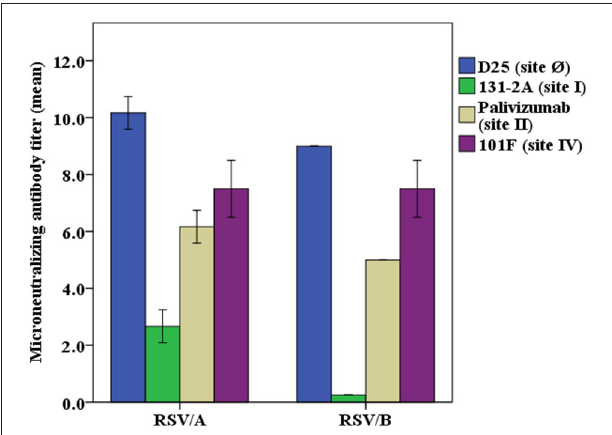
FIGURE 2 | Neutralizing potency of RSV antigenic site-specific monoclonal antibody. RSV/A Tracy and RSV/B 18537 were used in the experiments. The concentration of the mAbs were 40 µ g/mL for D25, palivizumab, 131-2A, and 101F in both RSV/A and RSV/B microneutralization assays, except that mAb 131-2A was used at 1.0 mg/mL in the RSV/B microneutralization assay. The Y axis is the RSV/A Tracy or RSV/B 18537 neutralizing antibody titers (log2) for different mAbs used in the microneutralization assay. Data represented are from 3 independent duplicate microneutralization assays ± standard deviation.